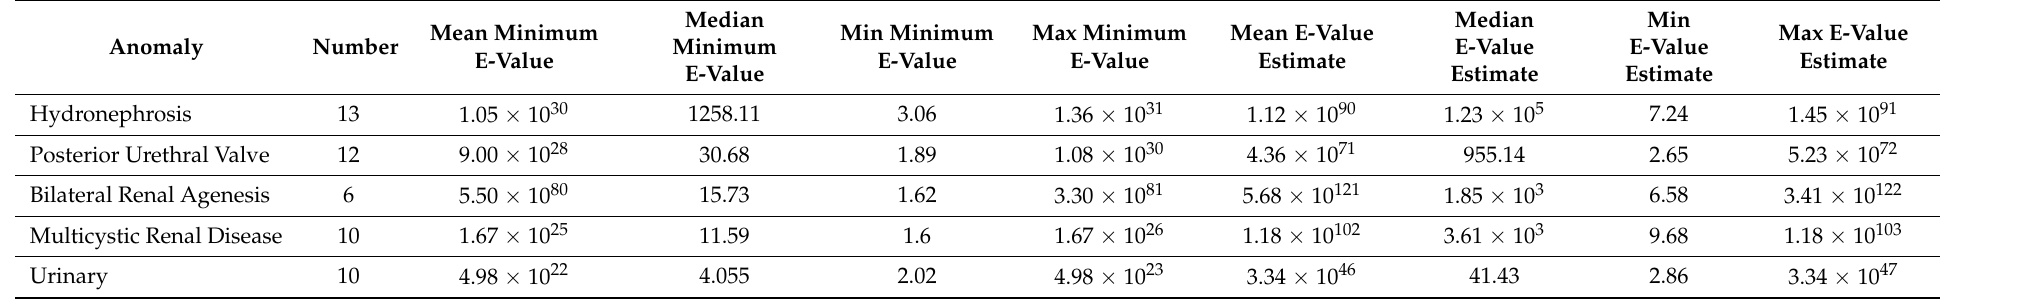
Table 12. Summary of E-Values by Anomaly.